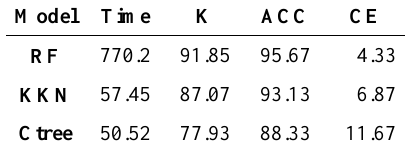
Table 3. Accuracy metric for the test set